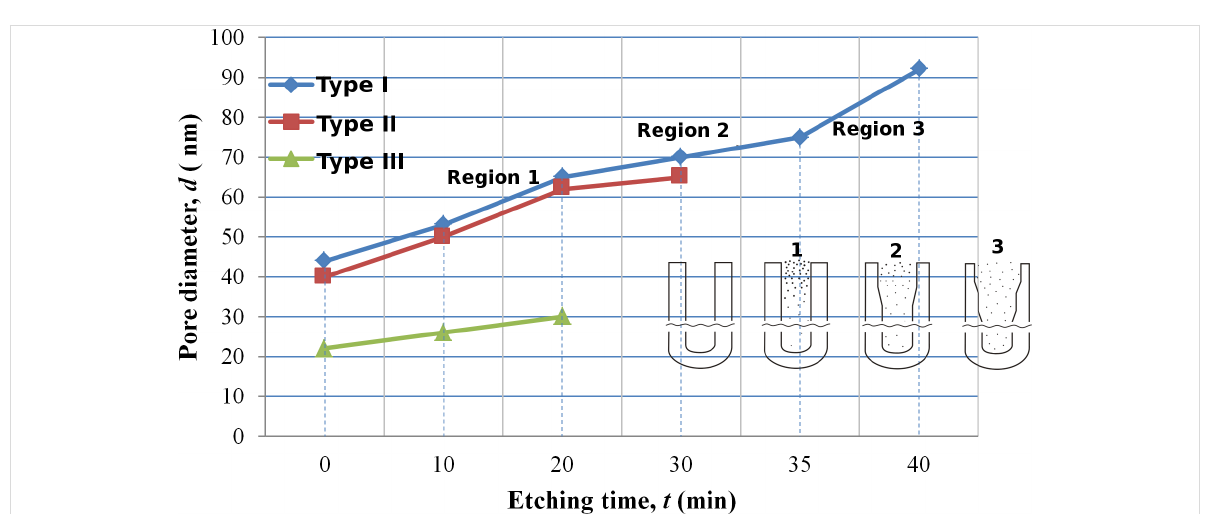
Figure 6: Pore diameter as a function of etching time of a barrier layer for PAA formed using the three synthesis condition schemes: Type I – in 0.3 M oxalic acid at a constant voltage of 50 V; type II – in 0.3 M oxalic acid at a constant voltage of 40 V; type III – in 1.5 M sulfuric acid at a constant voltage of 20 V. The temperature was held at 15 °C in all cases. The inset is a schematic describing the reaction occurring and correlating this to the three distinct trend regions (regions 1–3) for type